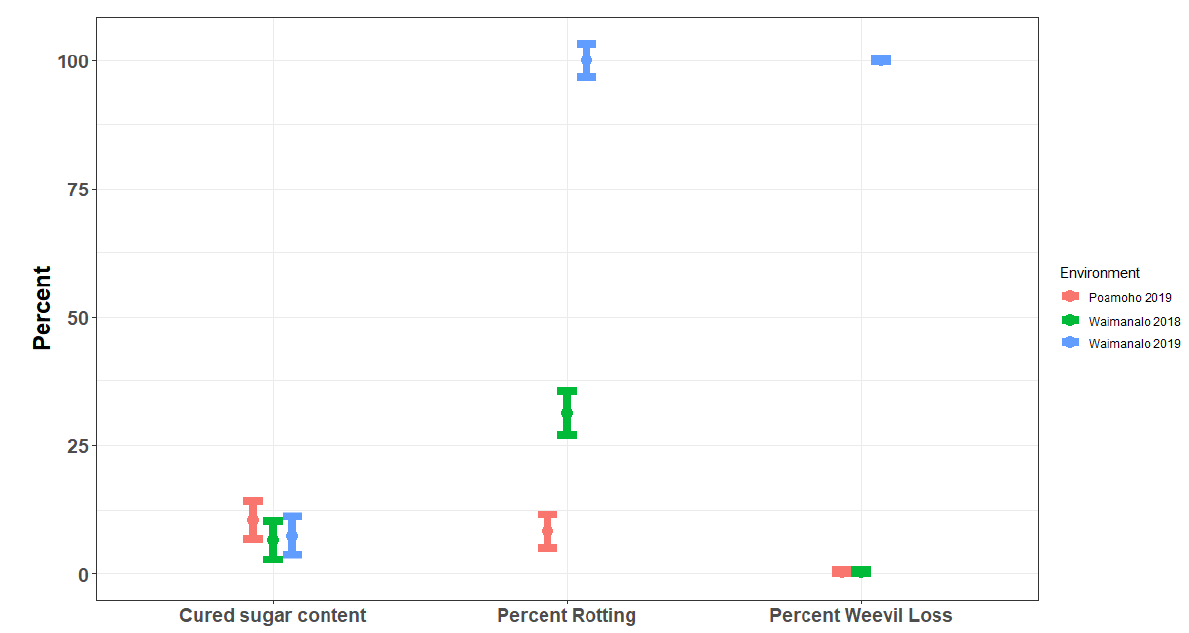
Figure 2. Comparison of performance at locations demonstrating the effect of planting location on phenotypic response. Each point represents the mean performance across all lines at a location, and error bars represent a 95% confidence interval around the mean line performance.